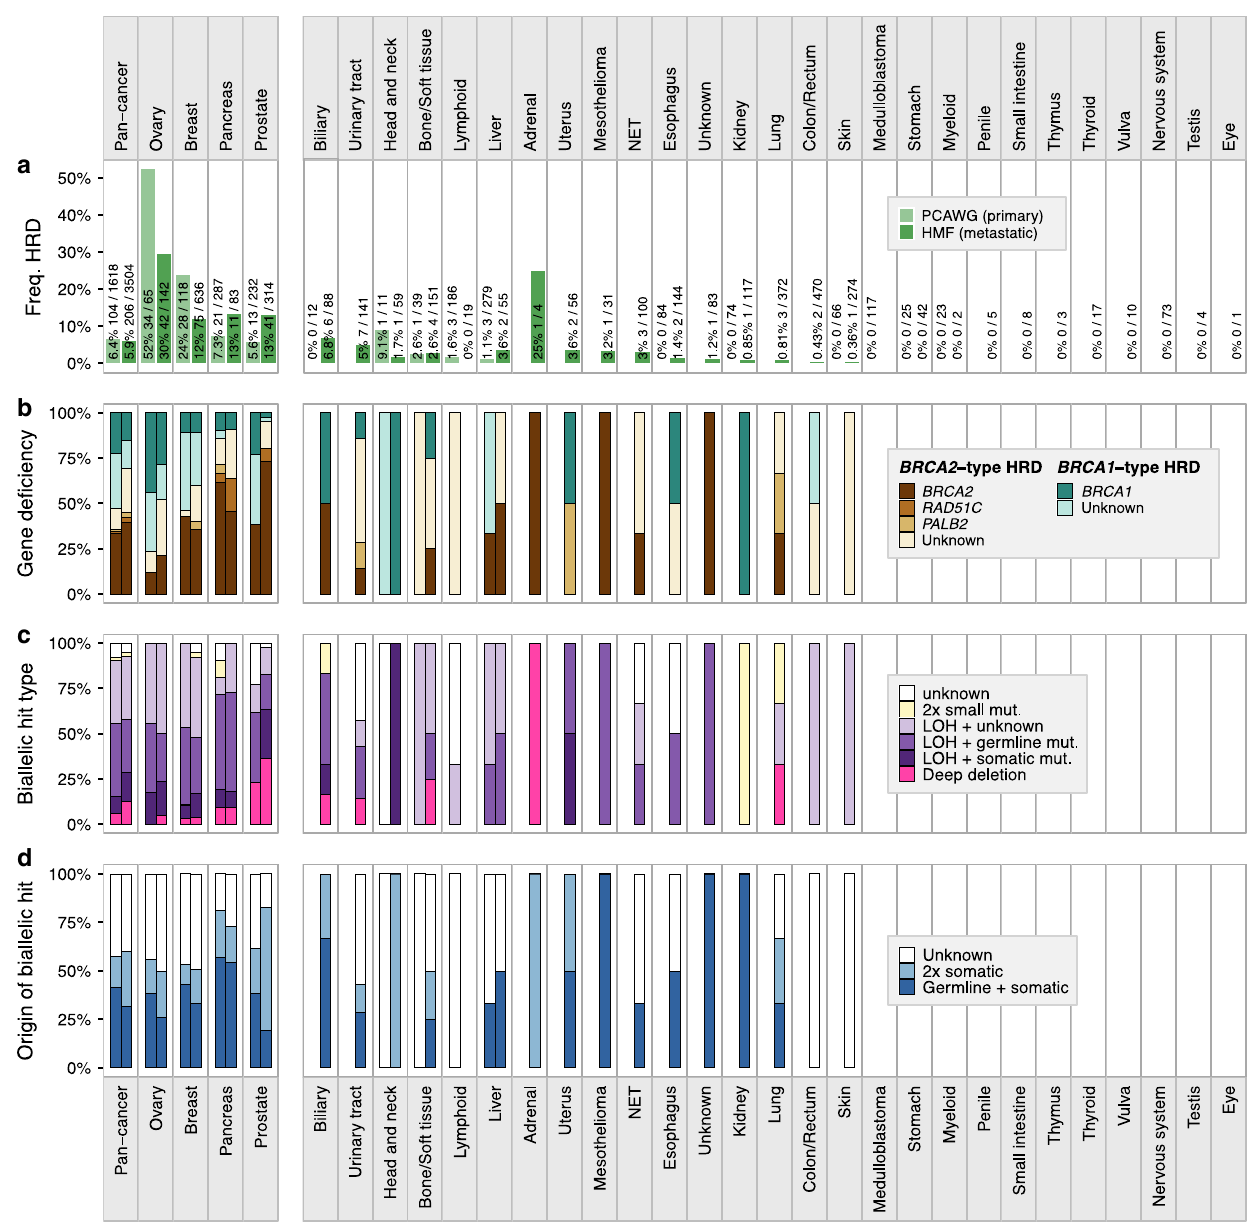
Fig. 4 Percentage breakdown of the incidence and genetic causes of HRD in CHORD-HRD patients pan-cancer and by cancer type. Left and right bars represent the HMF and PCAWG datasets respectively. The vertical split in the fi gure separates cancer types with (left side) and without (right side) ≥ 10 CHORD-HRD patients in at least one of the datasets. a Frequency of HRD. Cancer types where no frequency of HRD is displayed contain no data in either the HMF or PCAWG datasets. b The gene de fi ciency associated with HRD. Bar segments are grouped into BRCA2 -type HRD genes ( BRCA2 , RAD51C , PALB2 ) and BRCA1 -type HRD genes ( BRCA1 only). c The likely combination of biallelic events in BRCA1/2 , RAD51C or PALB2 causing HRD. d Whether the genetic cause of HRD was purely due to somatic events, due to germline predisposition, or unknown. In c , d , “ Unknown ” and/or “ LOH + unknown ” bar segments refer to patients where no clear biallelic loss of the aforementioned BRCA1/2 , RAD51C , or PALB2 was identi fi ed (i.e. clusters 4 and 6 of Fig. 3c). LOH: loss-of-heterozygosity. Only data from samples that passed CHORD ’ s QC criteria are shown in this fi gure (MSI absent, ≥ 50 indels, and ≥ 30 SVs if a sample was predicted